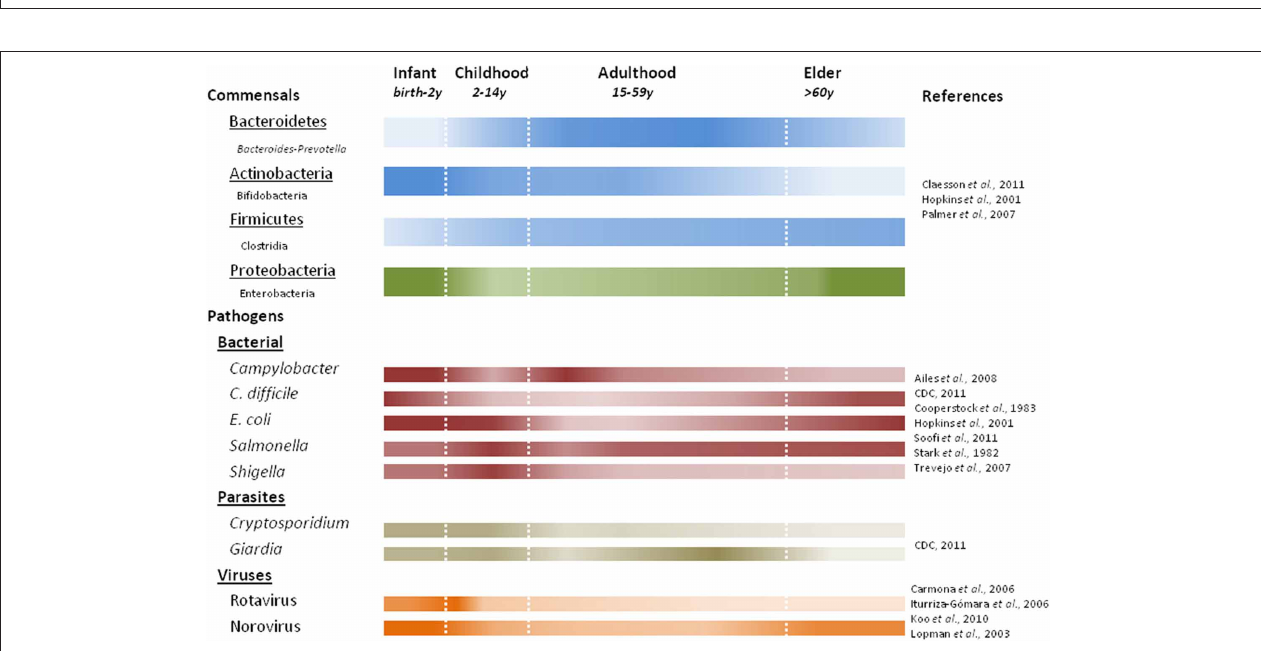
with examples listed below using noted references. Studies characterizing fecal microbiota prior to 2007 quantify the viable counts of bacteria, while later studies use DNA based